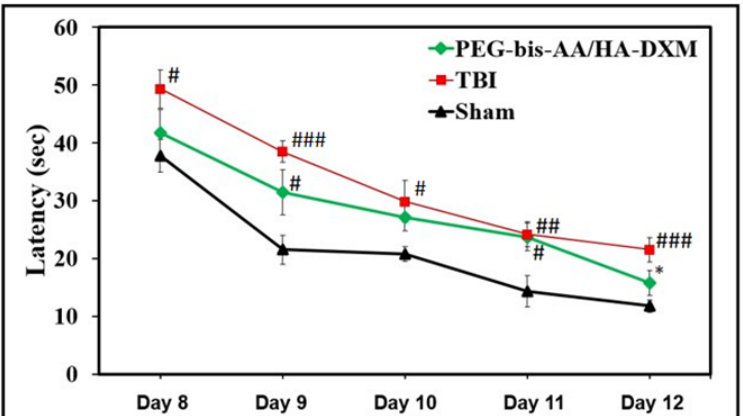
Figure 2. Effect of PEG-bis-AA/HA-DXM hydrogels on cognitive function by Morris water maze test with a hidden platform submerged in the southwest quadrant. Starting at 8 DPI, rats received 4 trials each day for 5 consecutive days. For each trial, each rat was allowed 60 s to search the pool for the submerged, hidden platform for all treatment groups; data presented as m ean ± SD; ONE -WAY ANOVA, post hoc: Tukey HSD; # p < 0.05, ## p < 0.01, ### p < 0.001 compared to sham; * p < 0.05 compared to TBI).